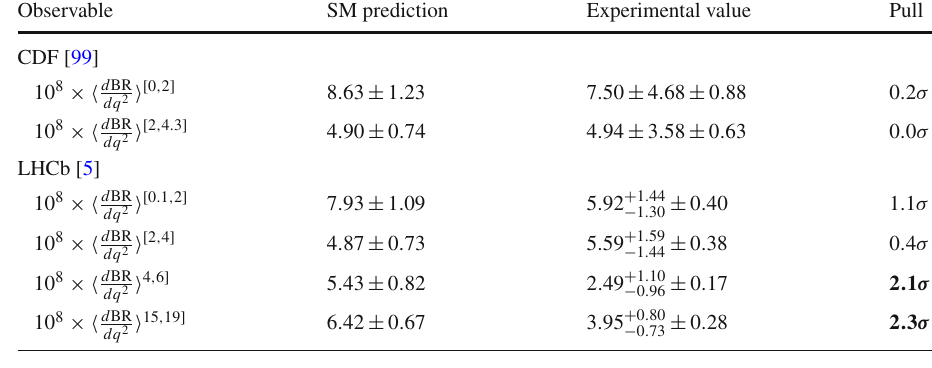
branching ratio of B 0 s → φμ + μ − included in the global